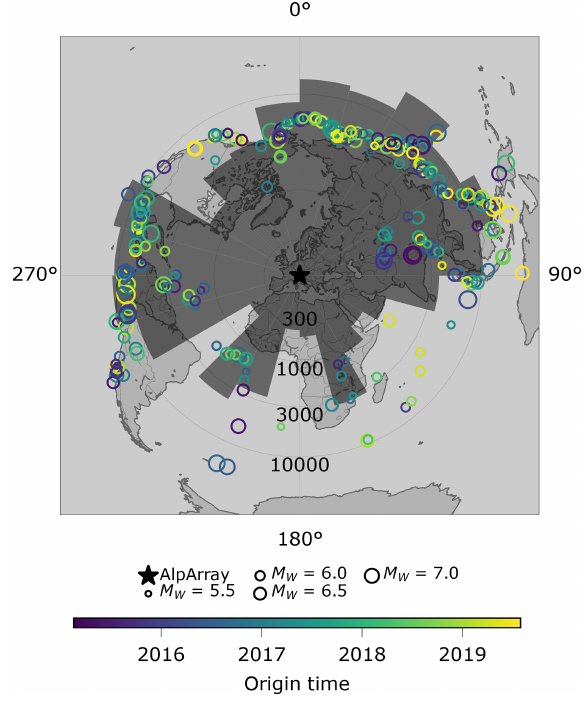
Figure 5. Distribution of the picks of 331 events of the high- frequency dataset db 0 . 5 . Size of circles correlates with moment magnitude, colour with origin time. Histogram shows number of picks on the logarithmic radial axis binned in 15 ◦ bins azimuthally. The distribution is very irregular with most events located in the northeastern quadrant and in a western sector. There are large gaps with few events especially from the south and southeast as well as from the northwest resulting in a reduced number of picks from these directions. Peak value is 20857 picks for the back-azimuth interval between 30 and 45 ◦ . The influence of the irregular dis- tribution will get visible when analysing resolution capabilities and smearing of the set-up and can be seen especially well in the checkerboard test (Sect. 4).